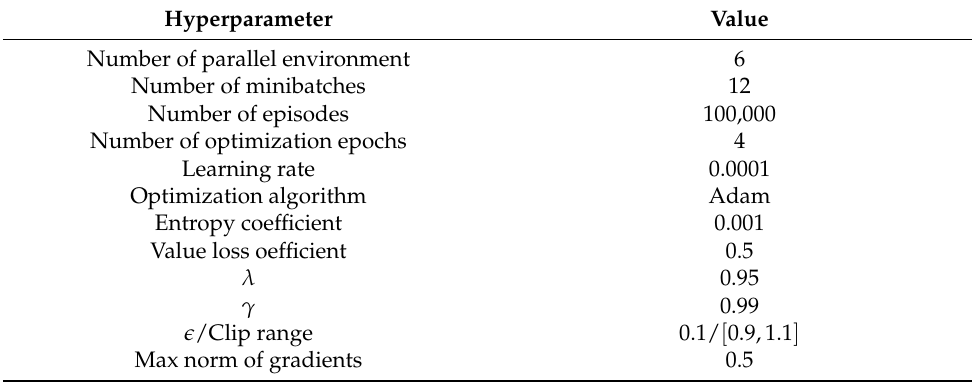
Table 2. PPO hyperparameter